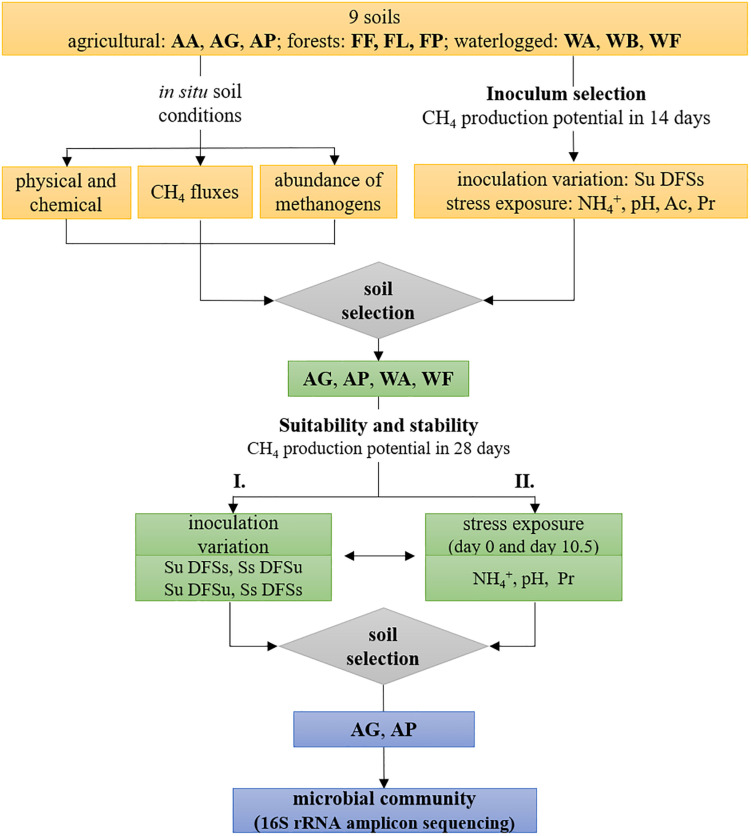
Schematic illustration of the experimental design including soil characterization, inoculum selection for anaerobic digestion using all nine initially chosen soils, and evaluation of four selected soils regarding their (i) suitability as potential inocula and (ii) stability against ammonium-, pH-, and propionate disturbance during anaerobic digestion, followed by 16S rRNA amplicon sequencing using the two most efficient soils. AA, arable land; AG, grassland with fermentation residue application; AP, pastureland; FF, beech forest; FL, larch forest; FP, spruce forest; WA, alluvial soil; WB, bog; WF, fen; Ac, acetate; Pr, propionate; Su, soil unsterile; Ss, soil sterile; DFSu, diluted fermenter sludge unsterile; DFSs, diluted fermenter sludge sterile.